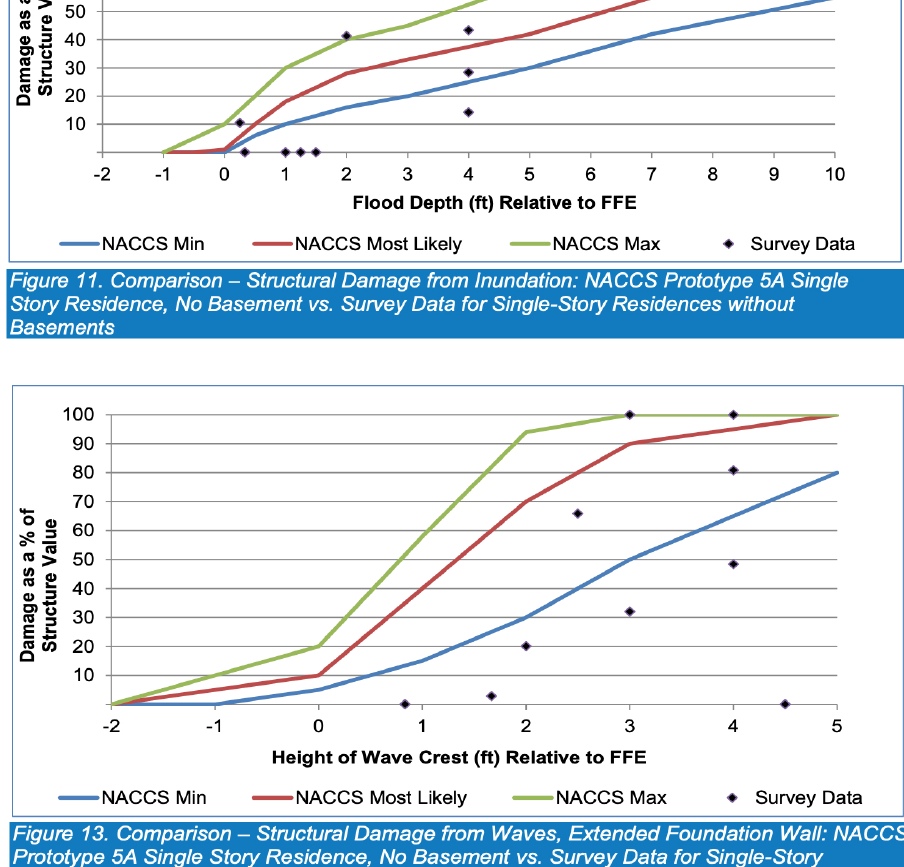
Figure 1. Structural damage from inundation ( upper panel) and waves ( lower panel) for the NACCS prototype 5A—single-story residence, without a basement vs. flood depth or wave crest height relative to FFE. The NACCS minimum, most likely, and maximum damage estimates are provided. Survey data (black dots) from hurricane Sandy (2012) are also provided. FFE is the First (Finished) Floor Elevation, relative to grade (Figures 11 and 13 from Simms et al. [8], (https://www.nad.usace.army.mil/Portals/40/docs/NACCS/10A_PhysicalDepthDmgFxSummary_26Jan2015.pdf, Accessed on 20 May